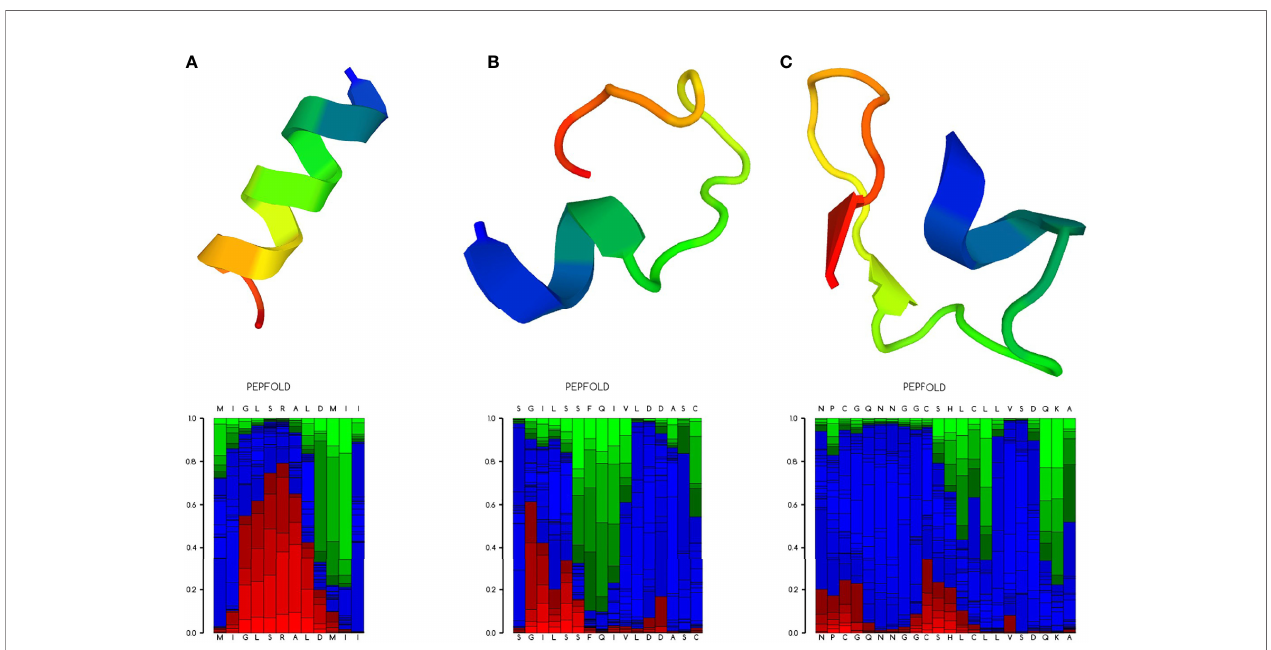
FIGURE 5 | Ribbon diagram of the selected antitumor peptide candidates. Amino acid sequences of the three peptide candidates were predicted for their peptide structures using PEP-FOLD3 (Lamiable et al., 2016). (A) Predicted peptide structure (upper panel) with the local structure prediction pro fi le (lower panel) of antitumor peptide 1. (B) Predicted peptide structure with the local structure prediction pro fi le of antitumor peptide 2. (C) Predicted peptide structure with the local structure prediction pro fi le of antitumor peptide 3. The pro fi le is presented using the following color codes: red, helical; green, extended; and blue, coil.